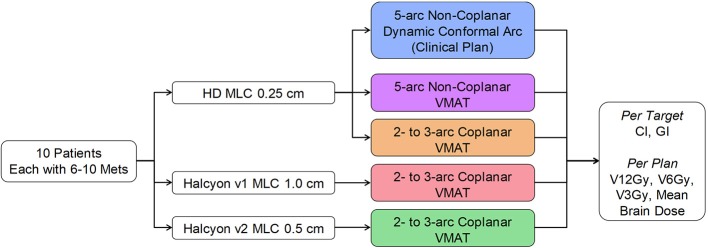
Study design flowchart.